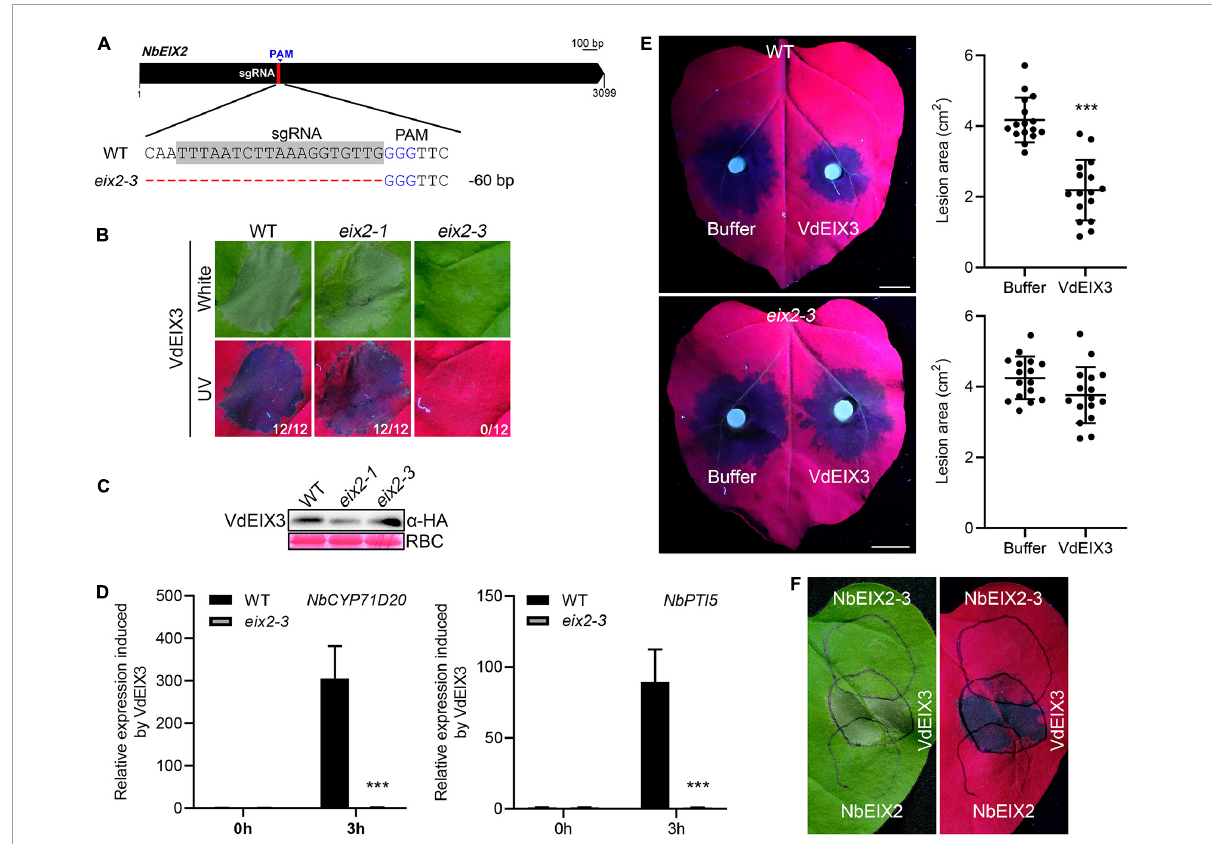
FIGURE3 The dominant negative mutant eix2-3 blocks VdEIX3-triggered immunity. (A) The eix2-3 mutant contains a 60 bp deletion. The sgRNA region is highlighted in gray. (B) VdEIX3 fails to induce cell death in the eix2-3 mutant by agroinfiltration. The photos were taken 3 days post infiltration under white and UV light, respectively. (C) Proteins expressed in Nicotiana benthamiana leaves were detected by immunoblot using anti-HA antibody. (D) Relative expressions of NbCYP71D20 and NbPTI5 induced by VdEIX3 protein in wild-type and eix2-3 mutant. Data are shown as mean ± SD (Student’s t -test, *** P < 0.001). (E) VdEIX3 protein fails to promote resistance to Phytophthora capsici in the eix2-3 mutant. Bars, 1 cm. Data are shown as mean ± SD (Student’s t -test, *** P < 0.001). (F) Transient expression of NbEIX2-3 in the wild-type N.